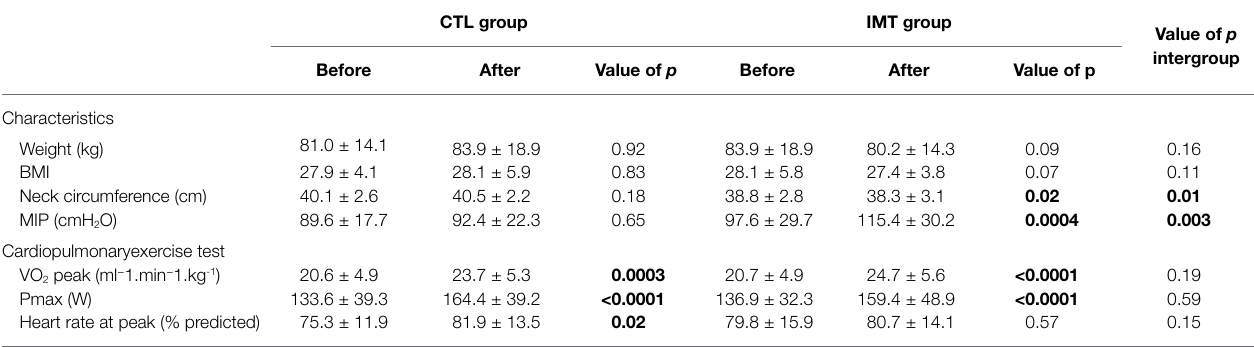
Value of p intergroup